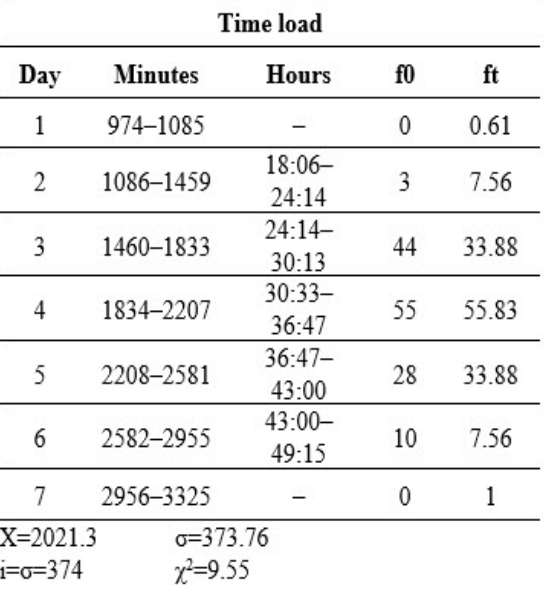
Table 8. Results (X and σ) by the suc -